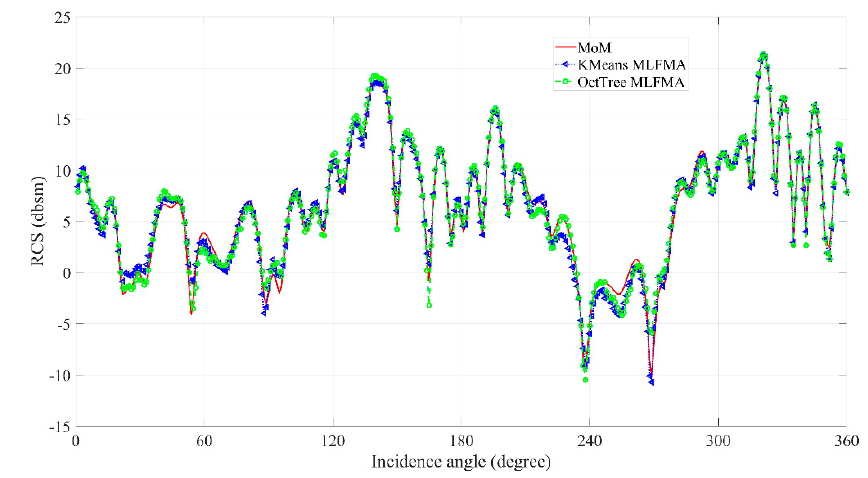
Figure 15. Monostatic RCS results of the F16 aircraft CAD model.